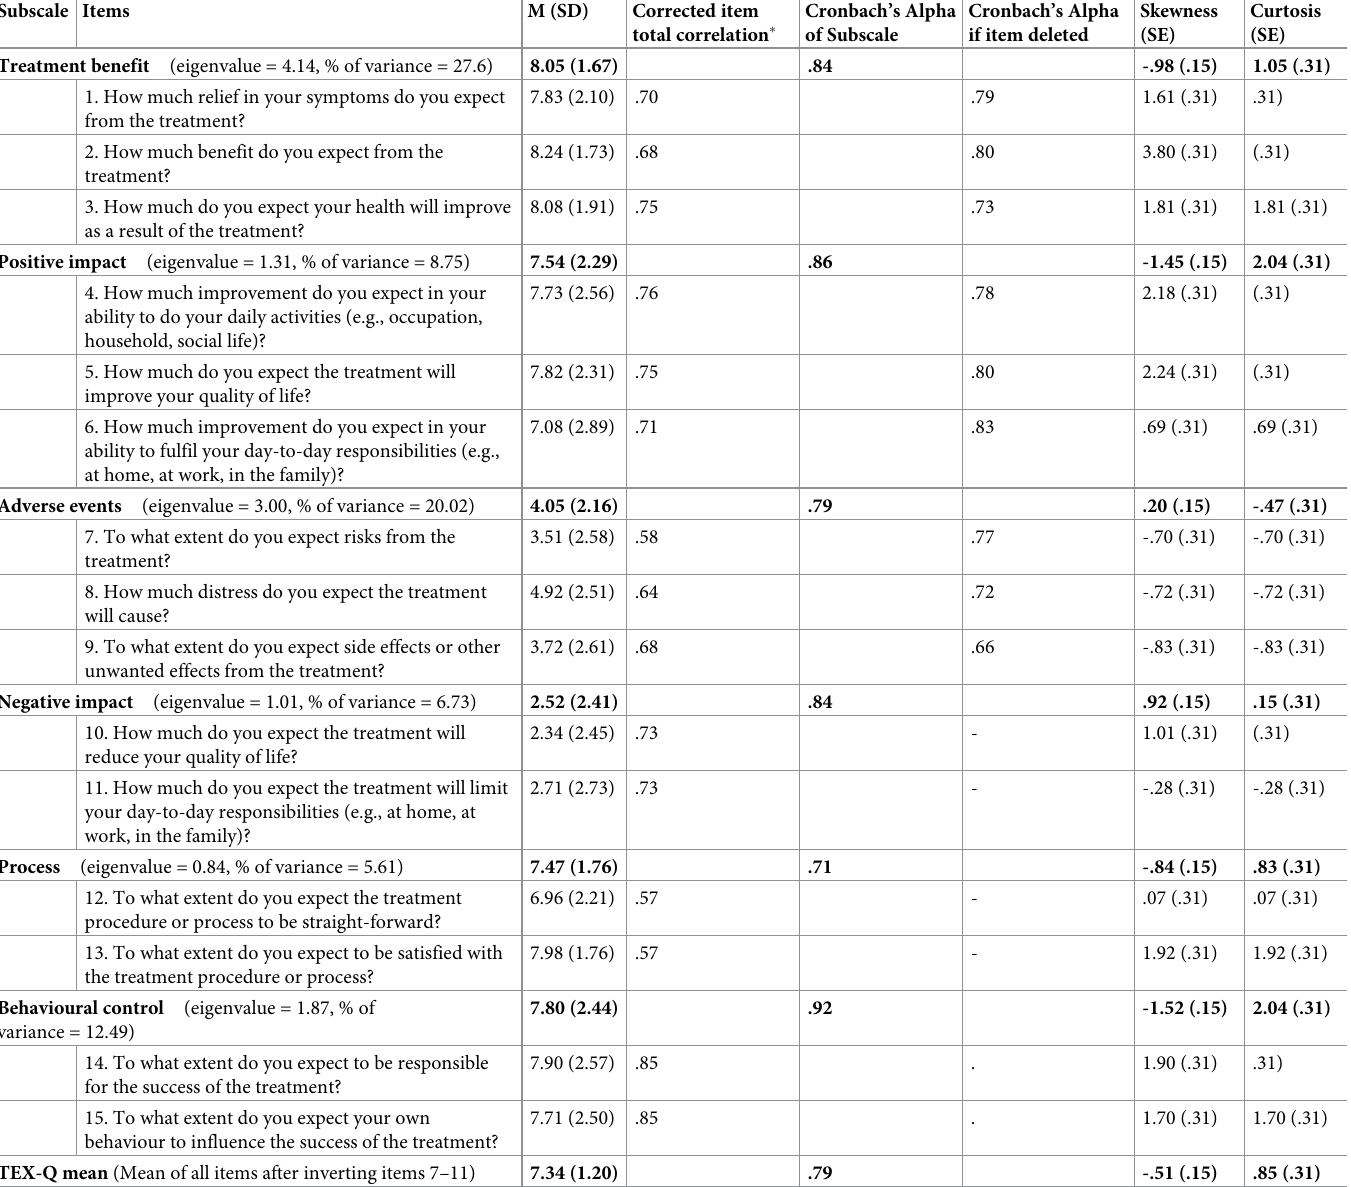
Table 2. Item Characteristics of the final Treatment Expectation Questionnaire (TEX-Q) in the validation sample (n = 251). Subscale